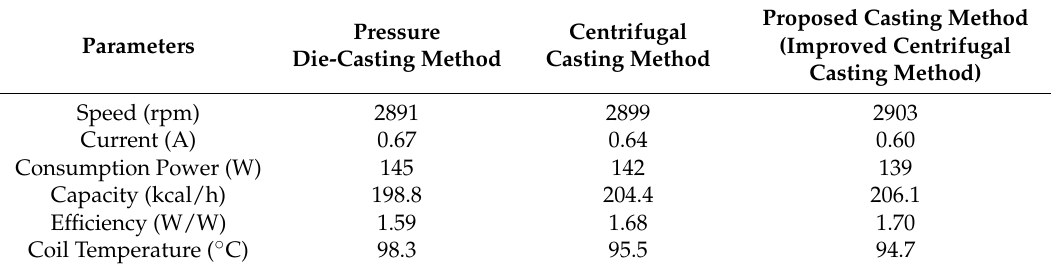
Table 8. The results of applying to stator #1 (220 V/50 Hz).